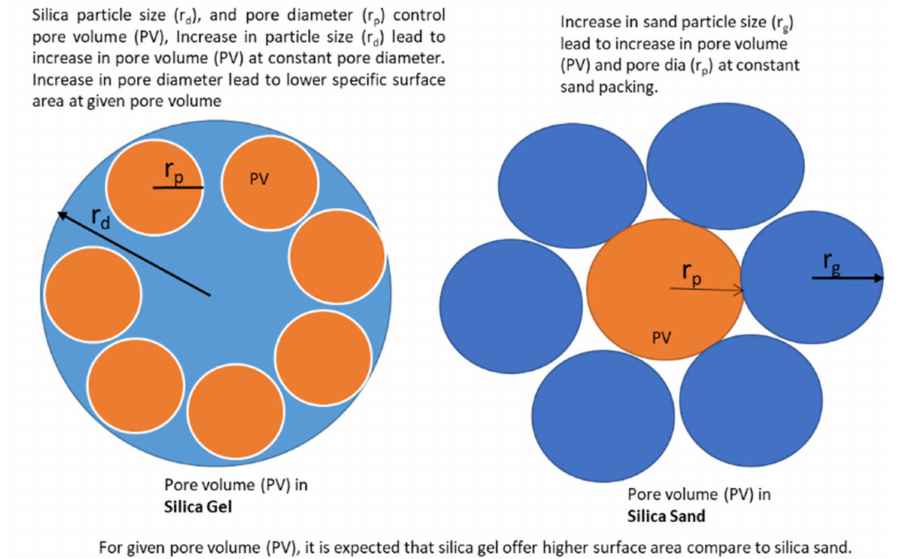
Figure 12. The di ff erence in silica sand and silica gel due to the di ff erence in pore volume and specific area that controls the gas uptake